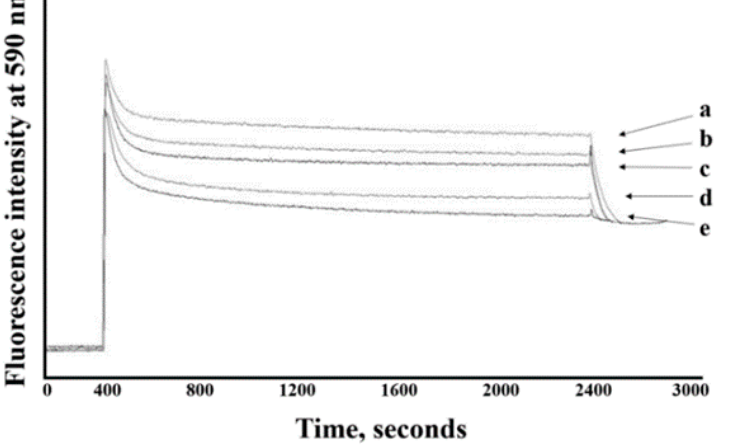
Figure 7. Effect of DHH on the pirarubicin (THP) accumulation in K562/ADR cells. a, vehicle control; b, 9.4 µM; c, 18.8 µM; d, 37.6 µM; and e, 56.4 µM.